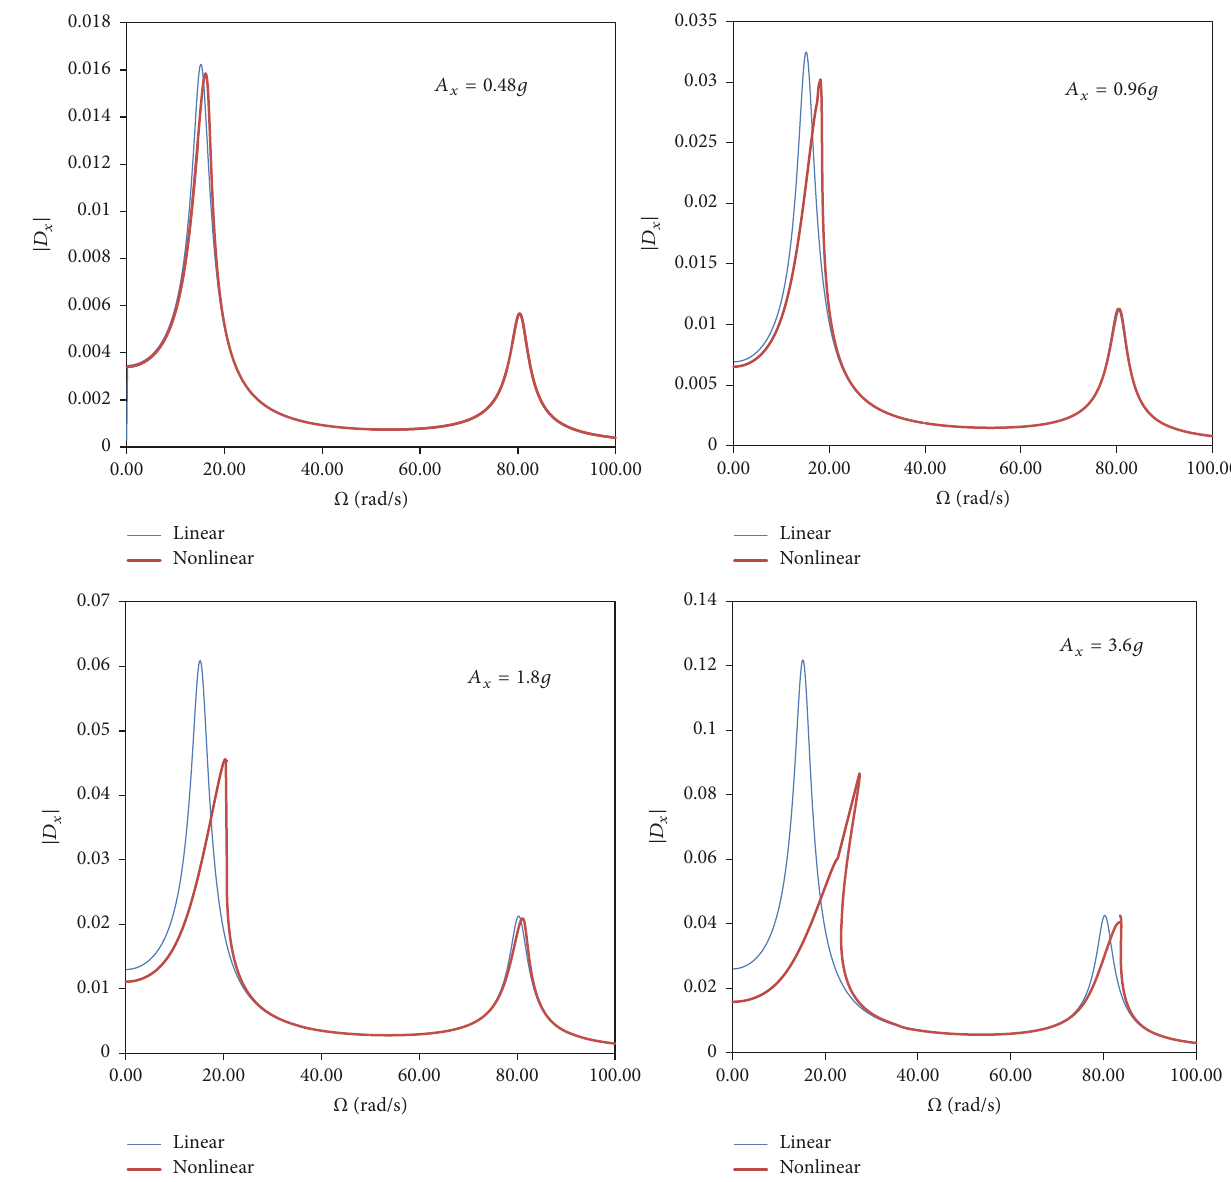
Figure 14: Influence of increasing magnitude 𝐴 𝑥 on the nonlinear response of the frame under horizontal excitation. Norm of the horizontal displacement at top of pitched-roof as a function of the forcing frequency. 𝐿 = 10 and 𝐻 = 6 m.